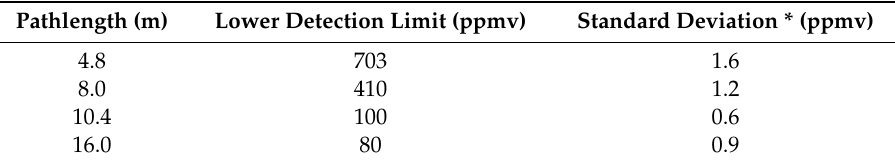
Table 2. Lower detection limits with respect to various pathlengths.